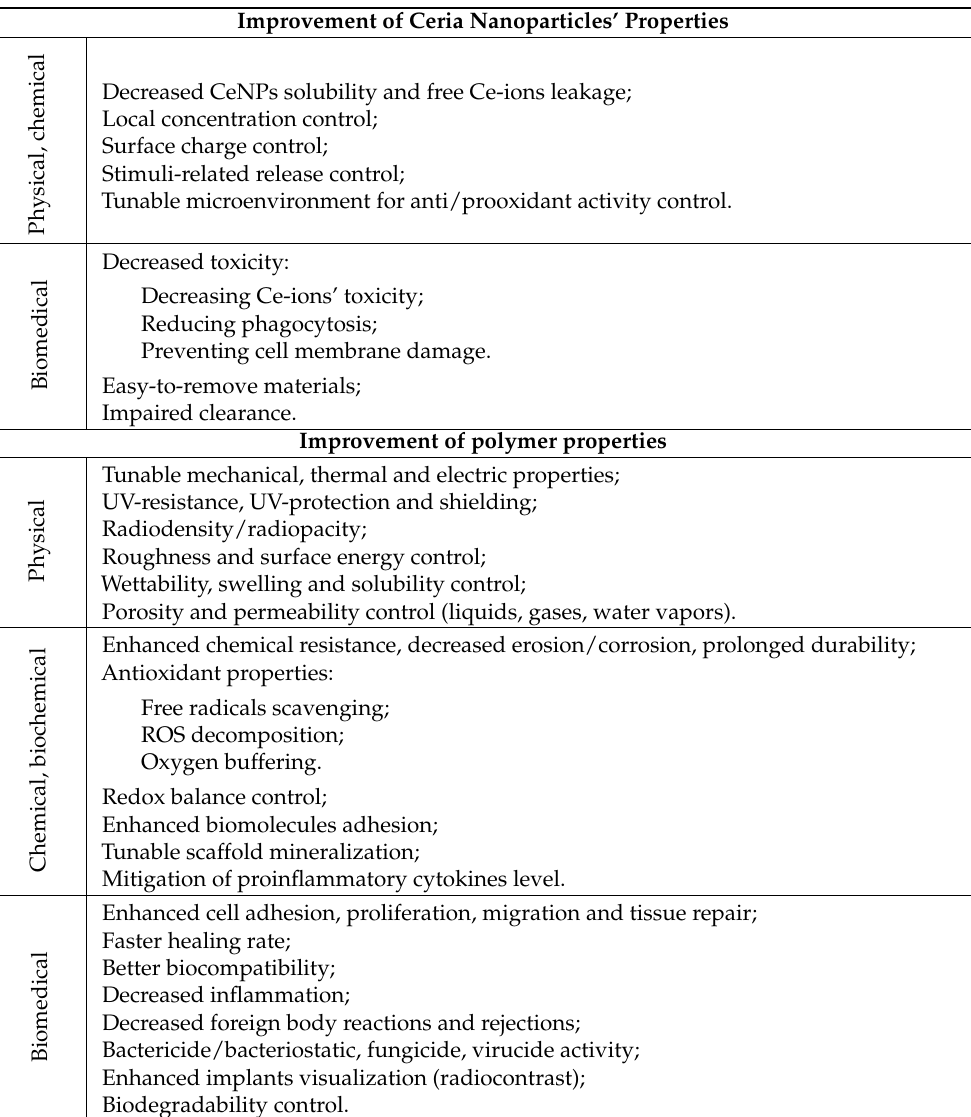
Table 2. Improvements to the properties of ceria nanoparticles and polymers by the development of ceria-polymeric